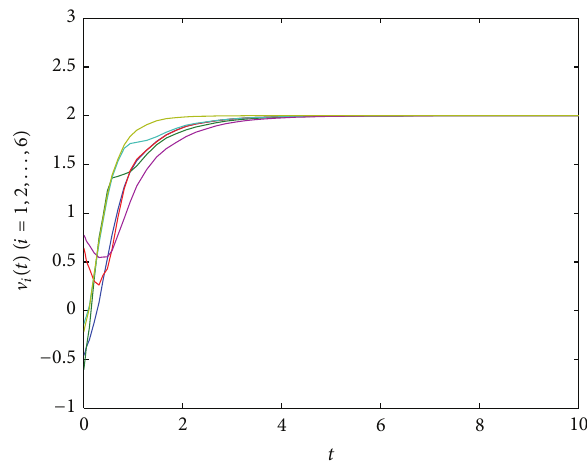
Figure 9: The velocity curves V 𝑖 (𝑡) (𝑖 = 1,2, . .. ,6) for nonlinear multiagent systems (45) with 𝜏 0 = 0 , 𝜏 1 = 0.2 , 𝜏 2 = 0.3 , 𝛽 1 = 0.1 , and = 0.9 𝛽 2